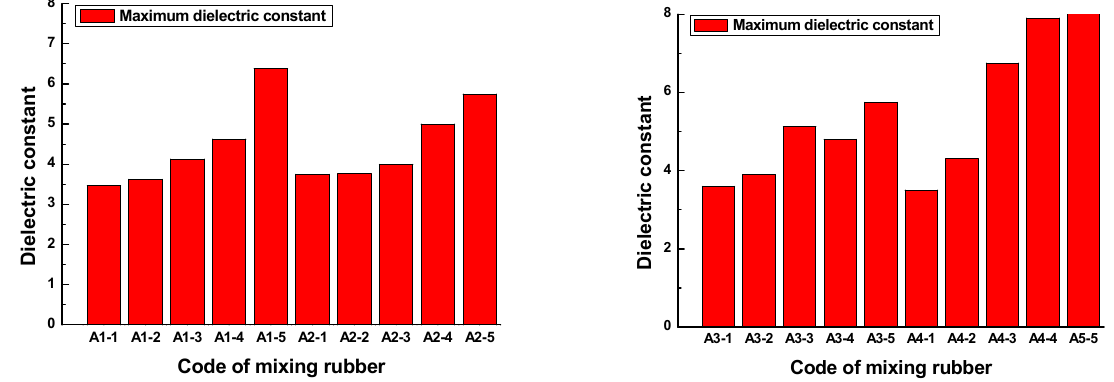
Figure 14. The maximum dielectric constant of the rubber sample. Figure 13 and Figure 14 show that the dielectric constant of the rubber sample in- creased with increasing CB content. The increased percentages of the maximum dielectric constant were 83.7%, 53.3%, 59.7%, and 142.9%, respectively. Comparing Figure13 (b) and Figure 13(d), and combined with Figure 14, it can be seen that the dielectric constant in-